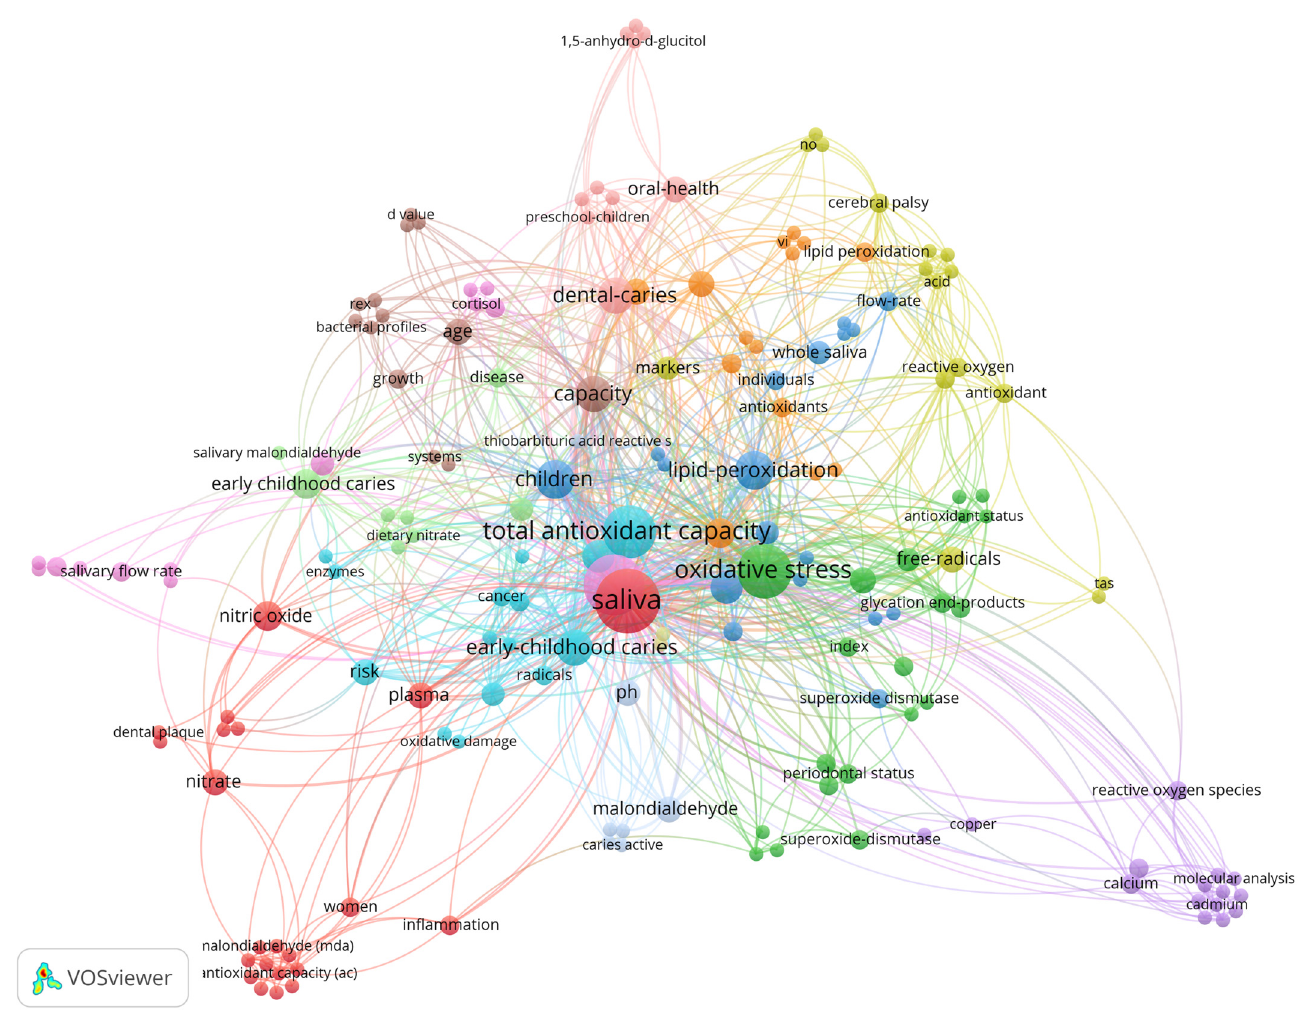
Figure 4. Network of co-occurrence of all keywords (author and keyword plus). The 180 keywords form 14 clusters. The size of the node represents the frequency of the keyword, with larger nodes indicating higher frequency.